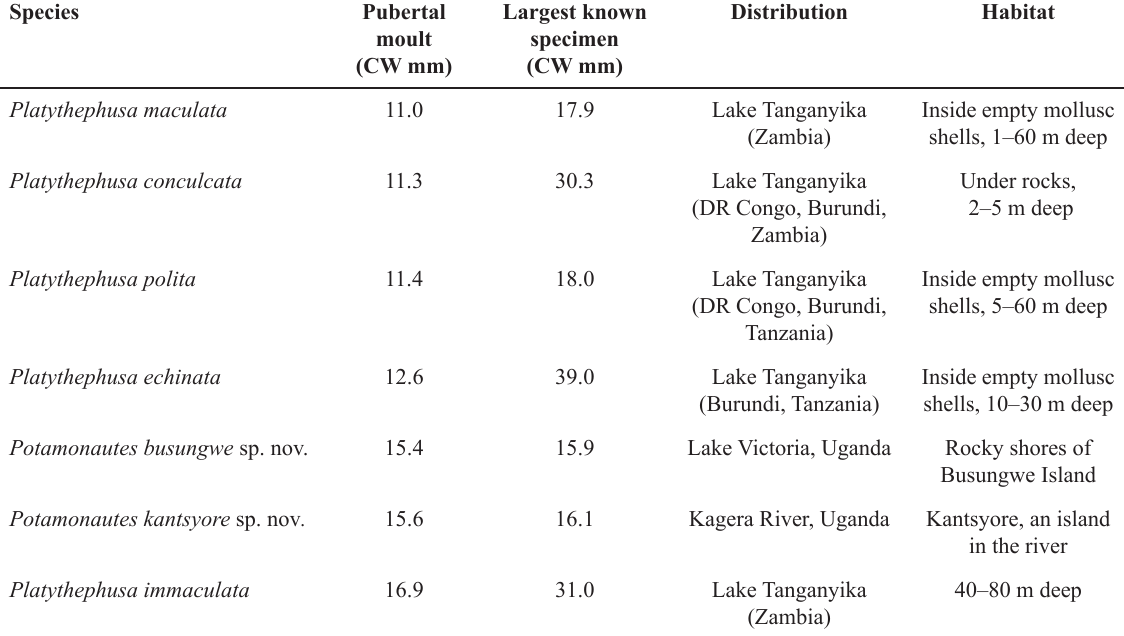
Table 3. Size range of the seven smallest known species of Afrotropical freshwater crabs. The range of the pubertal moult was estimated to be the size range between the carapace width (CW) of the largest subadult female and the CW of the smallest adult female. Based on Cumberlidge et al . (1999: table 2) and Marijnissen et al . (2004: table 2). See text for a discussion of how to establish the size range of a species of freshwater crab and for the taxonomic authorities of the species in this